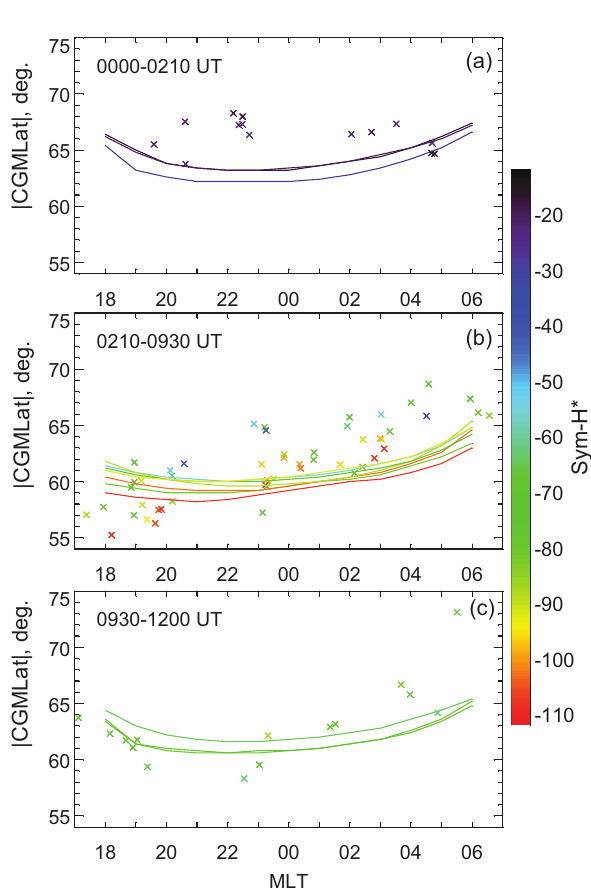
Fig. 7. Observed (symbols) and model (curves) isotropic bound- aries during (a) prestorm interval, (b) active phase of the storm and (c) recovery phase, shown as CGMLat vs. MLT. Color shows cor- responding Sym-H ∗ index values.